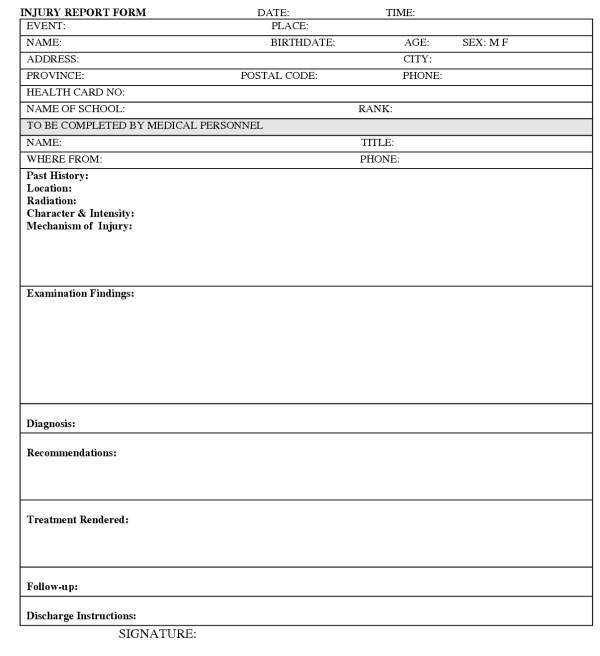
Injury data collection form.